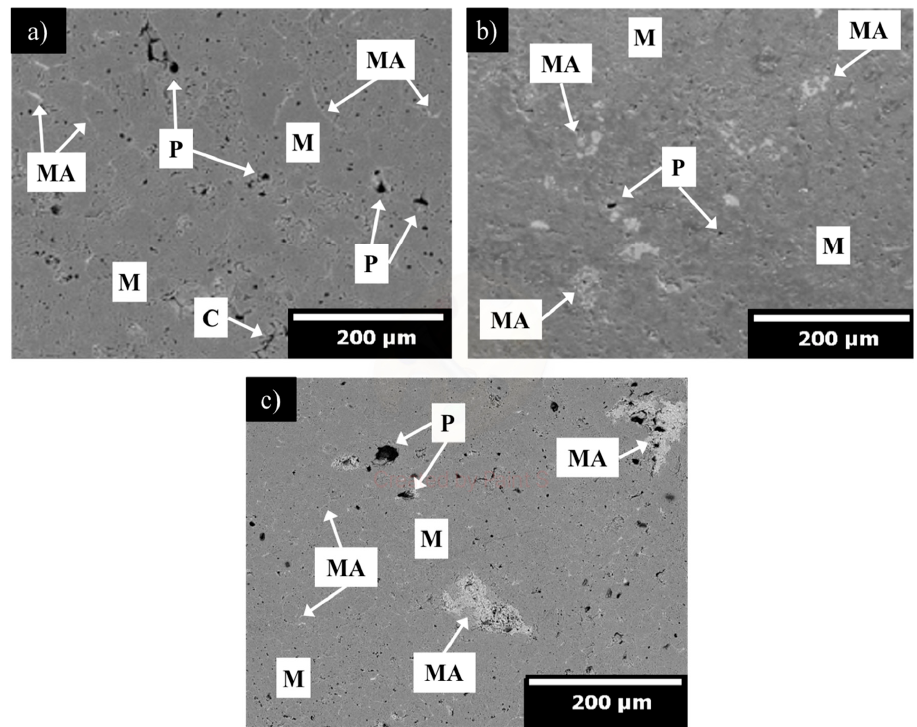
Figure 7. SEM micrograph of microstructural evolution of magnesia samples with increasing addition of α -Al 2 O 3 nanoparticles, sintered at 1500 °C. ( a ) 1, ( b ) 3, and ( c ) 5 wt.%. M = magnesia, C = microcracks, P = pores, and MA = MgAl 2 O 4 spinel. Materials 2020 , 12 , x FOR PEER REVIEW